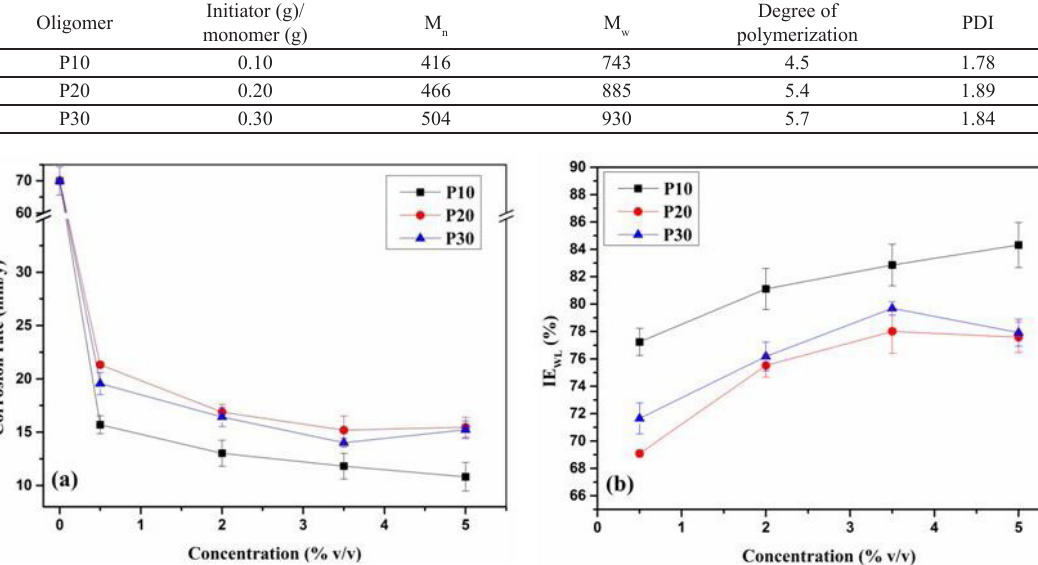
Figure 5. Effect of concentration on the corrosion rate (a) and inhibition efficiency (b) of P10, P20 and P30 in HCl 1M at 333 K.